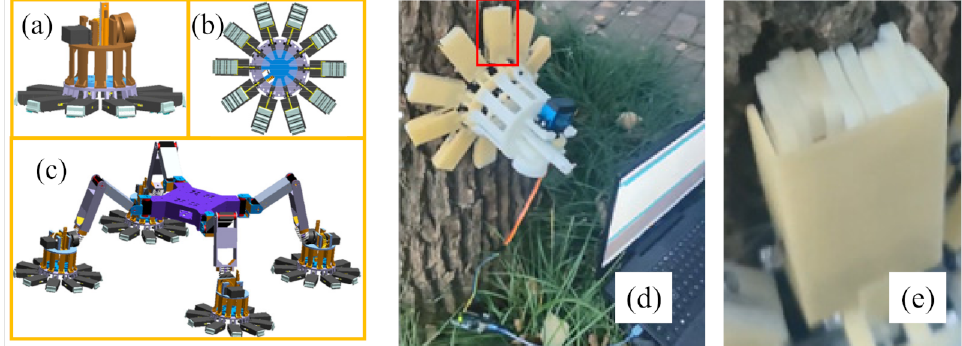
Figure 1. 3D model and prototype of the anchoring mechanism. ( a , b ) are front and bottom views of the anchoring mechanism; ( c ) 3D model of asteroid exploration robot; ( d ) The anchoring mechanism grabs the trunk ( e ) The microspine array grabs the